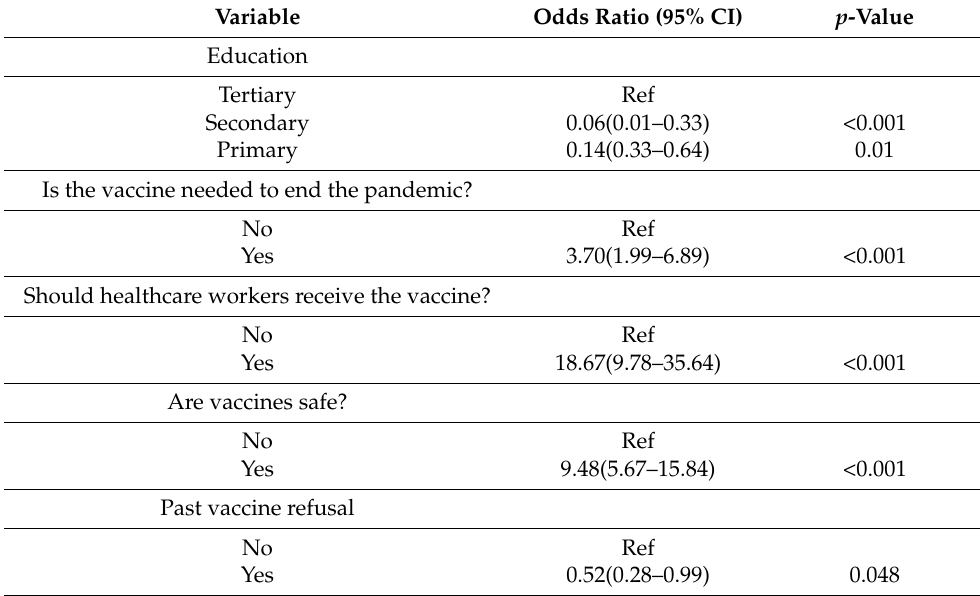
Table 3. Binary logistic regression analysis of factors associated with vaccine acceptance. Variable Odds Ratio (95% CI) p